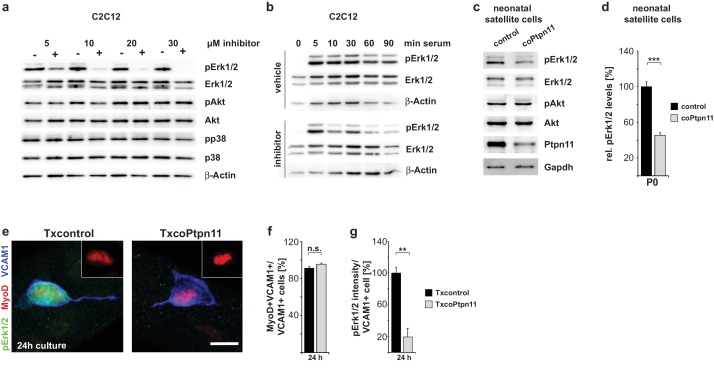
Ptpn11 controls Mapk/Erk1/2 activation in myogenic cells.(a) Western blot analysis of phosphorylation of Mapk/Erk1/2, PI3K/Akt and Mapk/p38 in C2C12 cells cultured in the presence of either vehicle or GS493 (5, 10, 20 and 30 µM). (b) Western blot analysis of Mapk/Erk1/2 phospho-rylation in C2C12 cells; cells were incubated for 6 hr in serum-free medium, and stimulated with 20% fetal calf serum in the presence/absence of GS493. (c) Western blot analysis of Mapk/Erk1/2 and PI3K/Akt in cultured neonatal satellite cells. (d) Quantification of Mapk/Erk1/2 phosphorylation. (e) Immunostaining of cultured fibers obtained from adult Txcontrol and TxcoPtpn11 mice. Satellite cells associated with the fibers are displayed, and pErk1/2 (green), MyoD (red) and VCAM1 (blue) staining is shown; the inset displays MyoD (red). (f) Quantification of VCAM1+ cells co-expressing MyoD. (g) Densitometric quantification of pErk1/2 staining intensity in VCAM1+ cells. n.s. = not significant, *p<0.05, **p<0.01, ***p<0.001. Error bars show S.E.M. Scale bar: 10 µm.